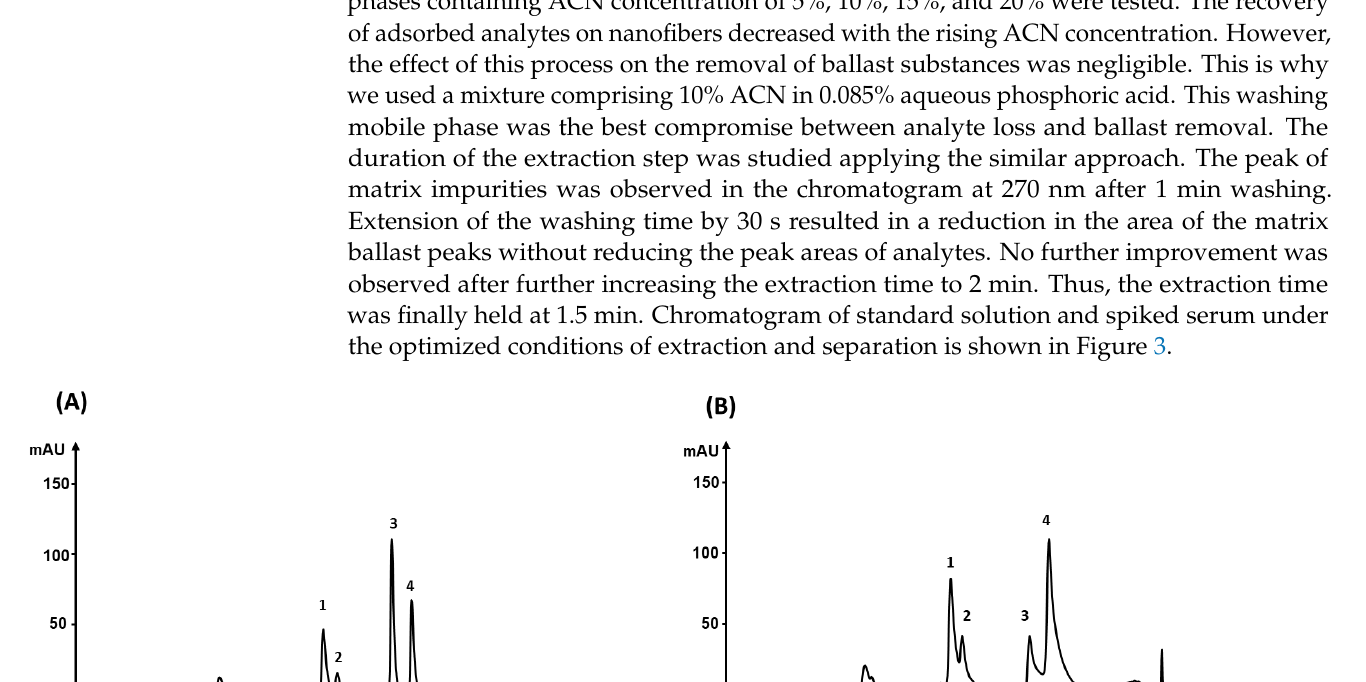
Figure 2. Chromatograms of standard solution spiked with 5000 ng mL − 1 NSAID separated on ( A ) Ascentis Express RP- Amide column and ( B ) Ascentis Express F5 column at a wavelength 270 nm. 1 — ketoprofen, 2 — naproxen, 3 — sodium diclofenac, 4 — indomethacin .